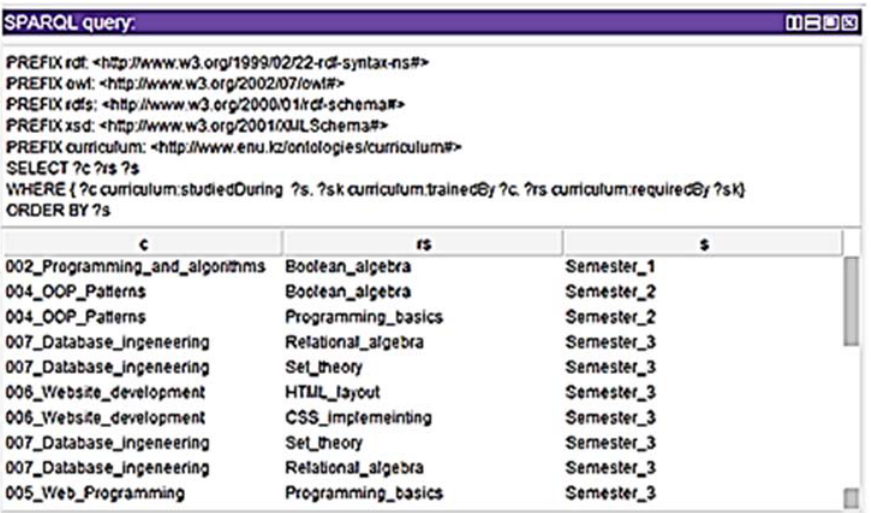
Figure 15. Entrance requirements (prerequisites) of the curriculum courses with the indication of the semester.